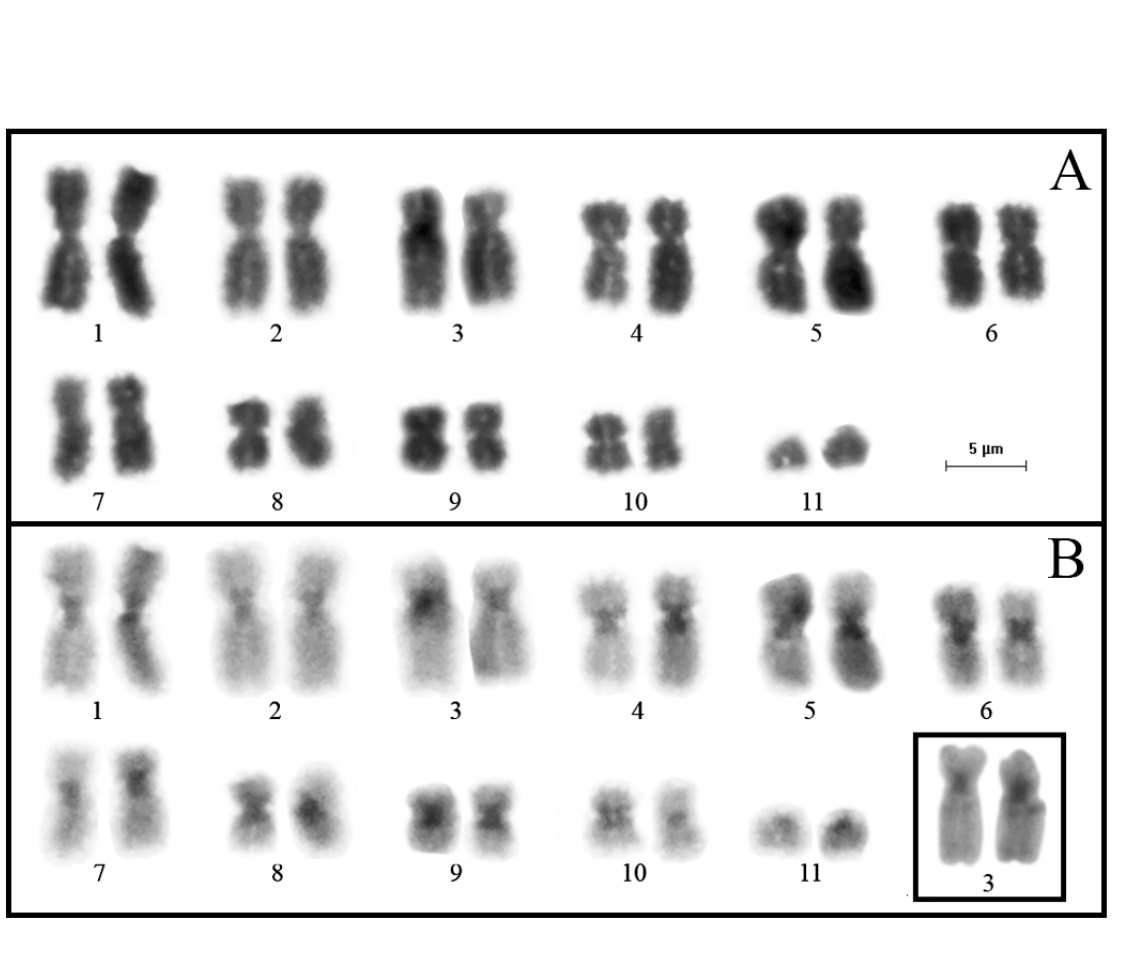
Fig. 7. Karyotype of Physalaemus araxa sp. nov. A . Giemsa-stained. B . C-banded. The insert in B shows the faint C-band on chromosome pair 3.